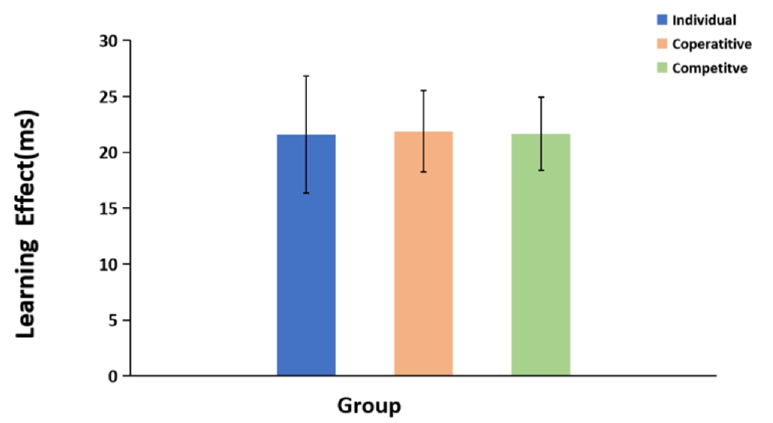
Figure 3. Median reaction times (RTs) of the individual group, cooperative group, and competitive group across the learning process (epochs 1–4). The error bars indicate the standard error. The general learning effect was calculated as the median RT of the first epoch, minus that of the fourth epoch and is shown in Figure 4. The general learning effect for each group was analyzed by one-way ANOVA. The results showed that the main effect of the group was not significant, F (2, 75) = 0.154, p = 0.999, η 2 < 0.001, demonstrating that the situation of cooperation or competition had no effect on the general learning effect for each group.